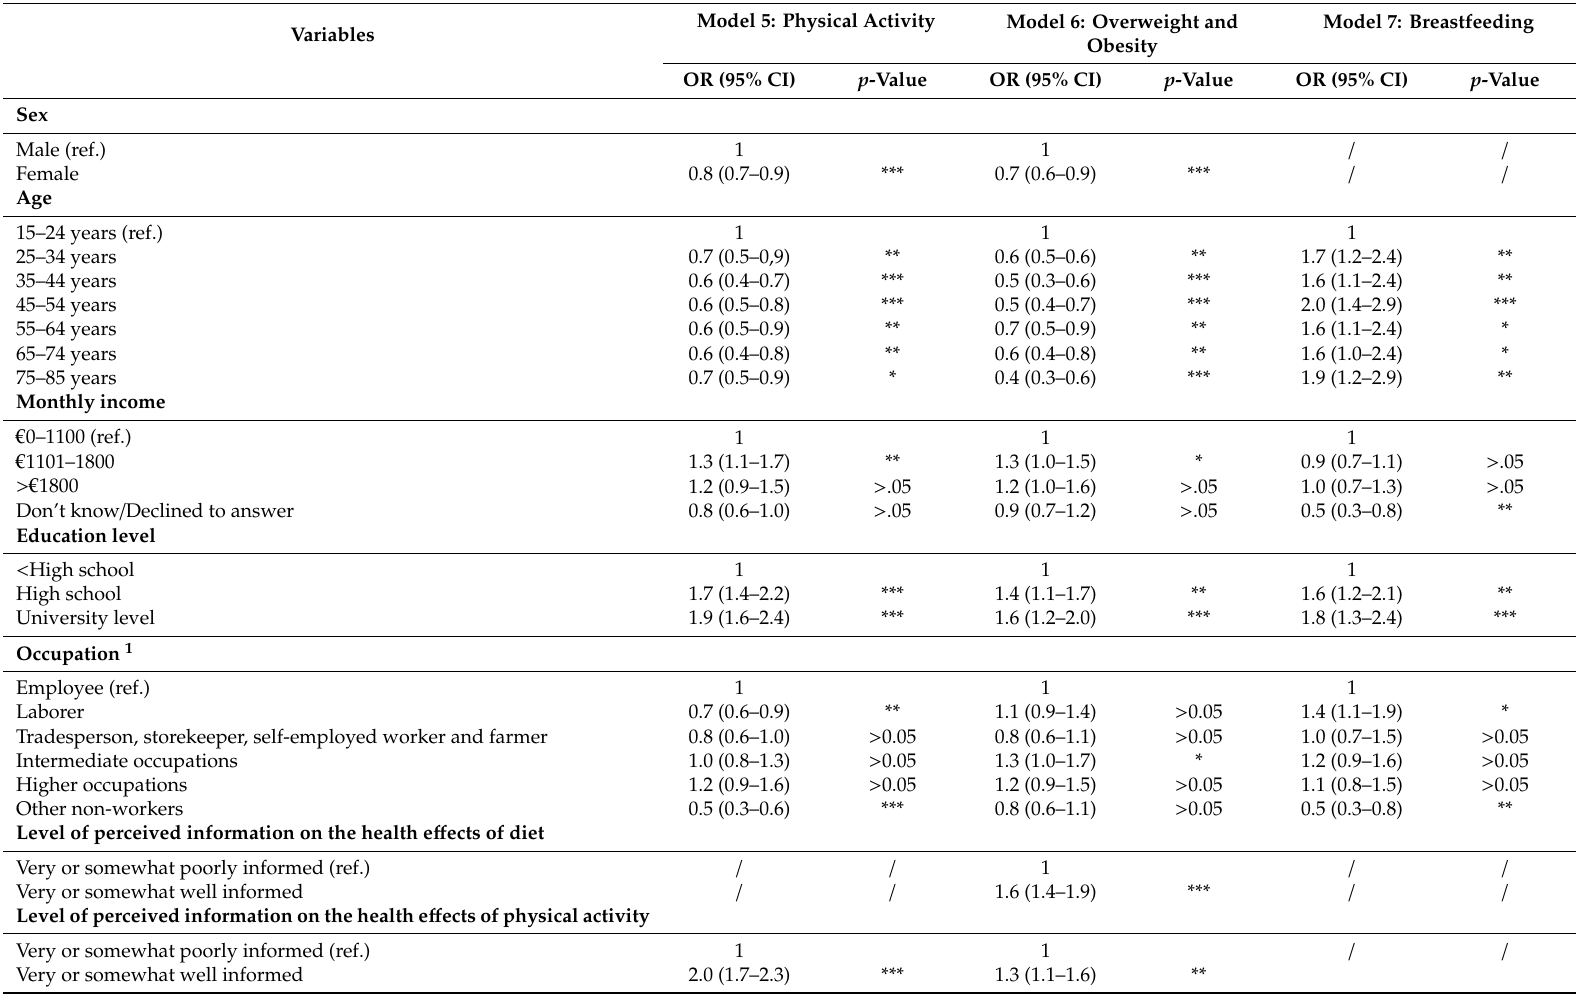
Table 6. Physical activity ( n = 3764), overweight and obesity ( n = 3762), and breastfeeding ( n = 1918 women) as factors associated with cancer risk. Model 5: Physical Activity Model 6: Overweight and Model 7: Variables Obesity